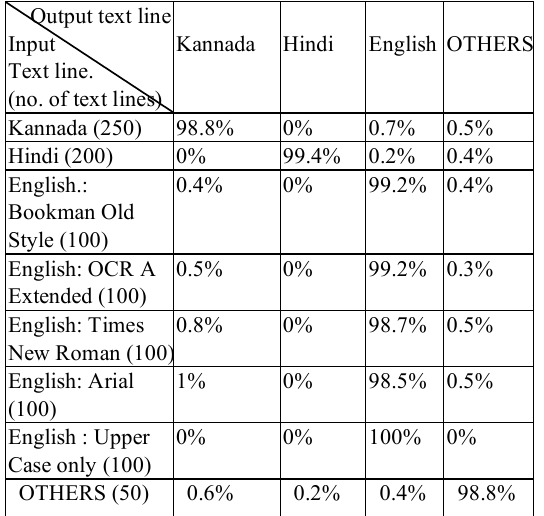
Table 3. Percentage of experimental results of line-wise language identification model.